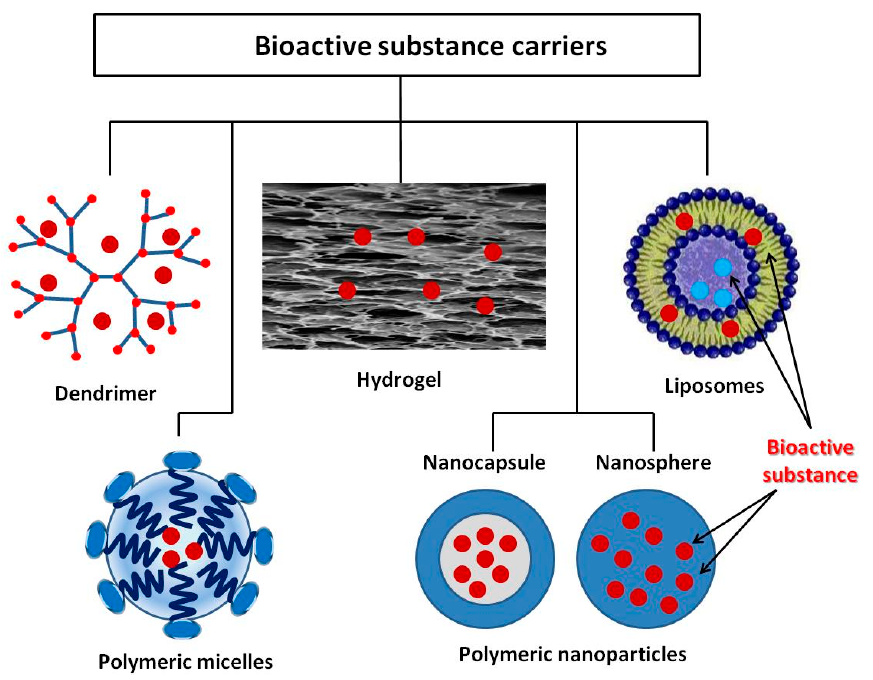
Figure 3. BAS delivery carriers. 360